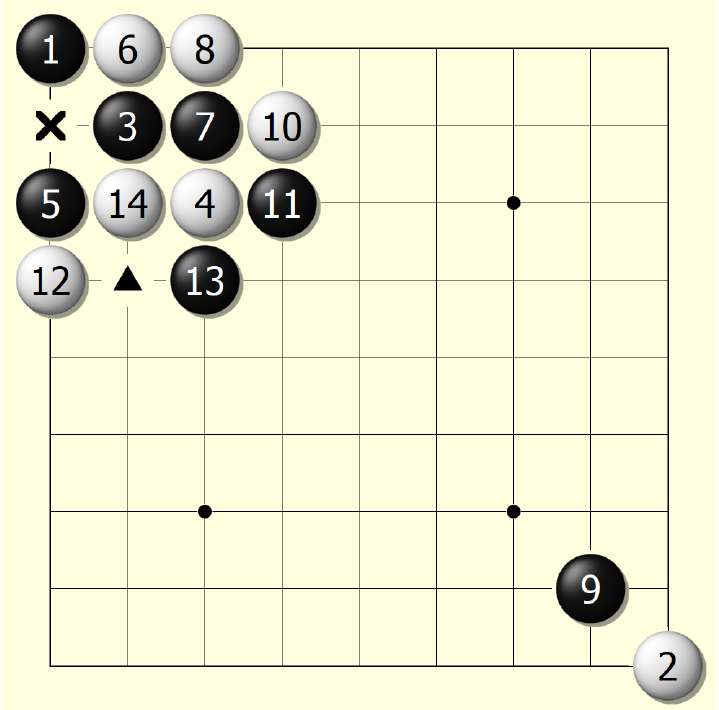
Figure 9. Demonstration of predictive strategy. When black tried to build a triangle structure in Step 3, instead of chasing black’s step like the behavior shown in Figure 8, white took Step 4 and built a wider encirclement, thus rendering the triangle structure built by black (marked by ×)